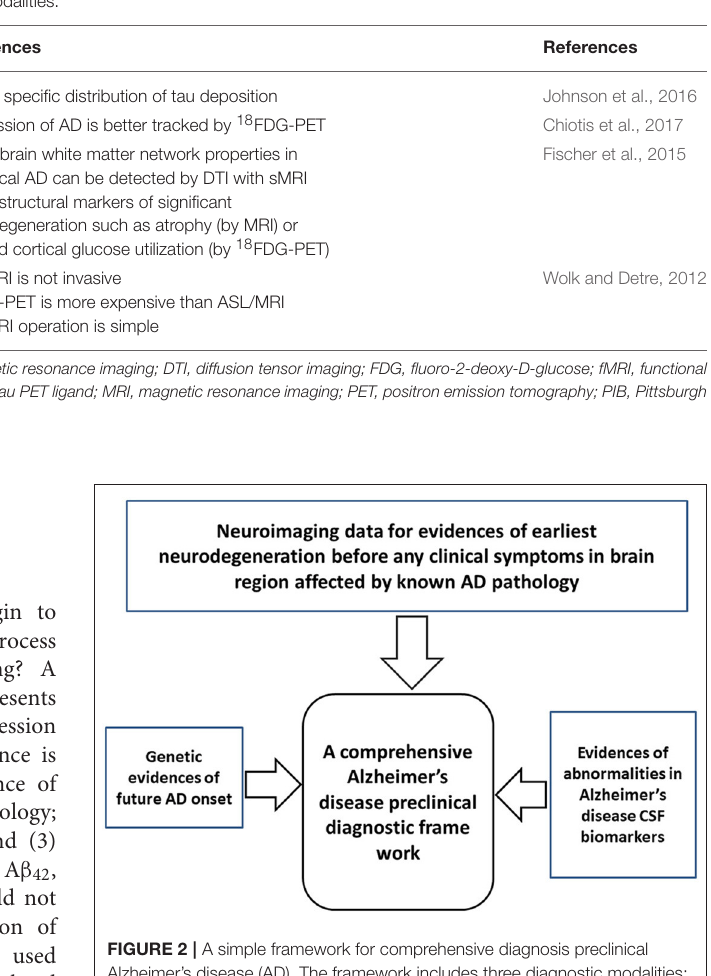
TABLE 3 | Comparison of preclinical Alzheimer’s disease neuroimaging modalities.